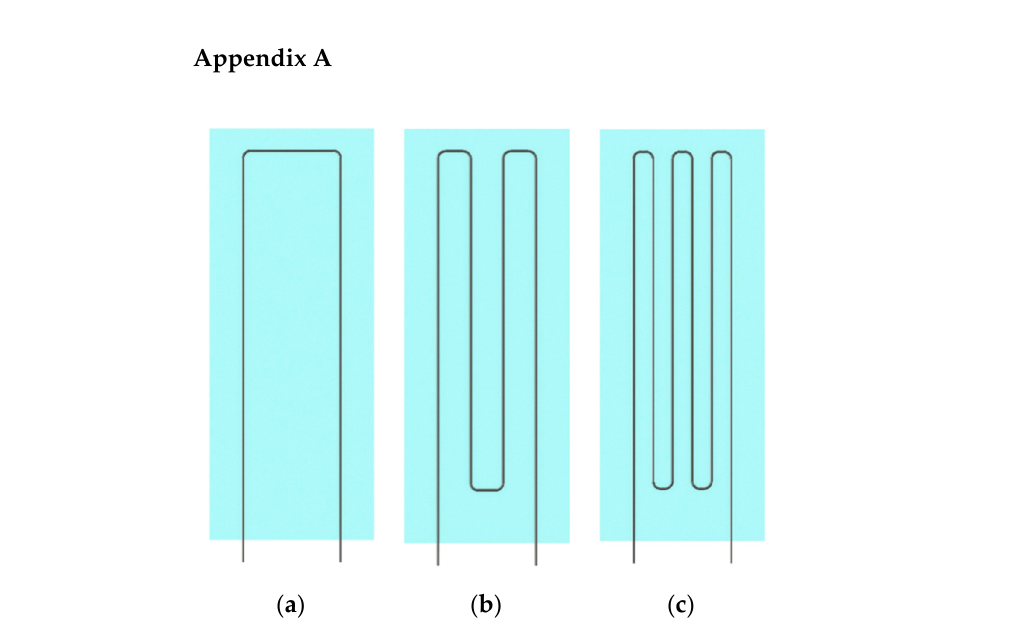
Figure A1. Configurations for multiple wire arrangements. ( a ) 2-wire configuration; ( b ) 4-wire configuration; ( c ) 6-wire configuration.